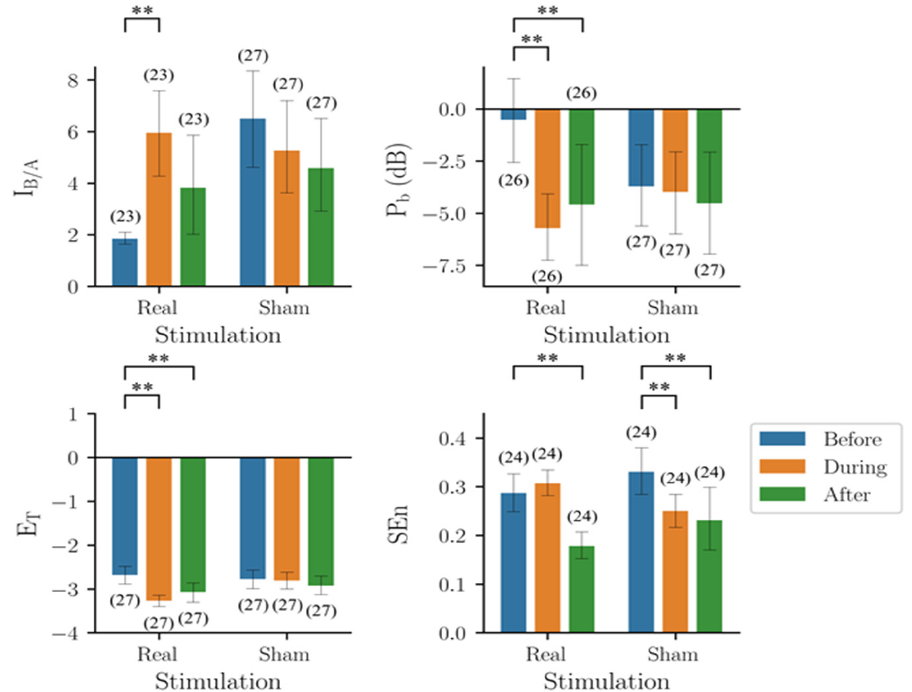
Figure 7. Results of the four indicators on the EEG segments collected from mice before, during, and after regular pulse stimulation. I B/A : estimated B/A from CSCKF, P b : band power in the frequency range of 4–50 Hz, E T : Teager energy operator, and SEn: sample entropy. The colored bar shows the mean value of each group, and the error bar shows the corresponding range of ± 1 standard deviation. The number within the parentheses is the number of EEG segments, where the outliers have been excluded by the 1.5 inter-quartile range rule. **: Significant difference ( p -value < 0.01) tested by using non-parametric Wilcoxon signed-rank tests.